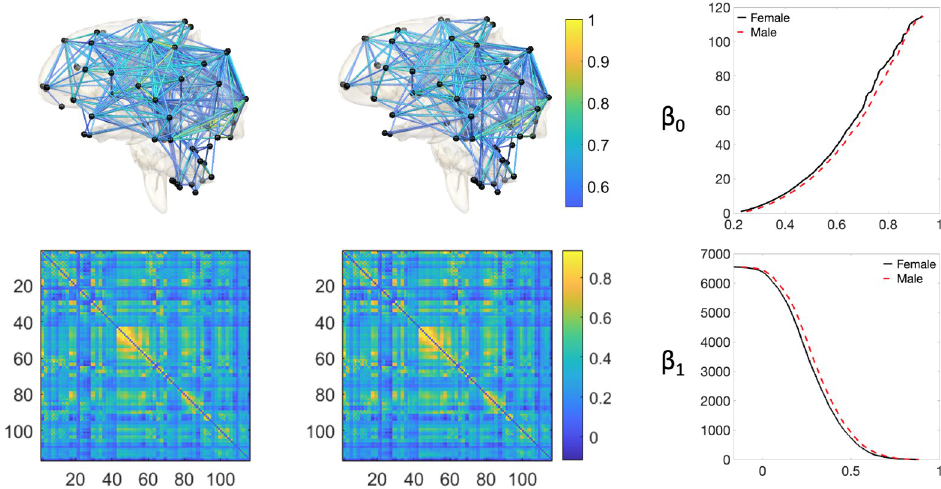
Fig 7. Visualization of the fMRI brain data. Left panel: The average female brain network (top) and the corresponding correlation matrix (bottom). Middle panel: The average male brain network (top) and the corresponding correlation matrix (bottom). Right panel: The β 0 (top) and β 1 (bottom) curves for female (in solid black) and male (in dashed red) brain networks. For a better visualization, we consider a threshold value of 0:5 while plotting the brain networks so that they contain fewer number of